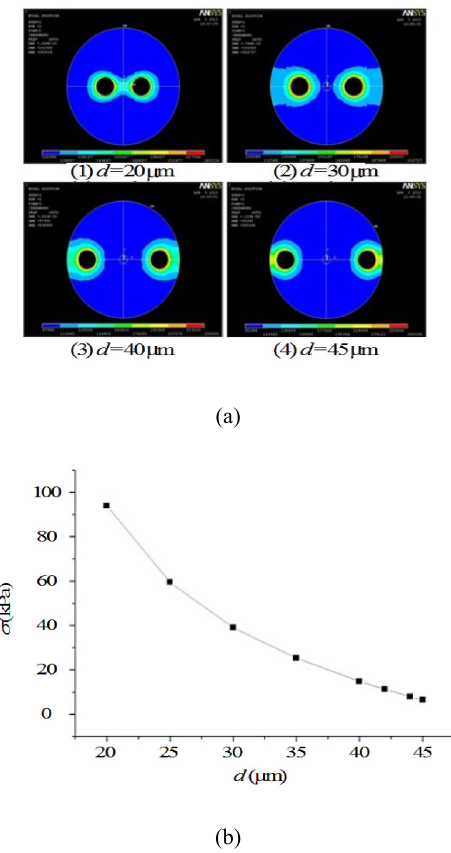
Fig. 3 Strain distributions of the circular-core side-hole fiber: (a) the strain field distribution of different side-hole fibers with fixed holes radius of 10 µ m and the lengths between the core and holes corresponding to 20 µ m, 30 µ m, 40 µ m, and 45 µ m, respectively) and (b) strain difference versus length between the centers of the core and